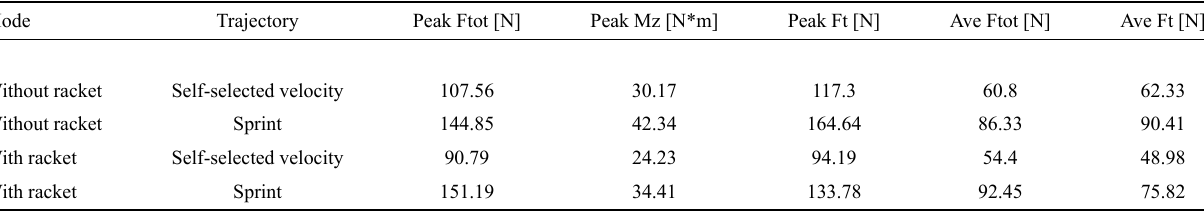
Table 3 - Average push characterization (measured by the SmartWheel system), in two movement trajectories, with and without the racket in the right hand. Mode Without racket Without